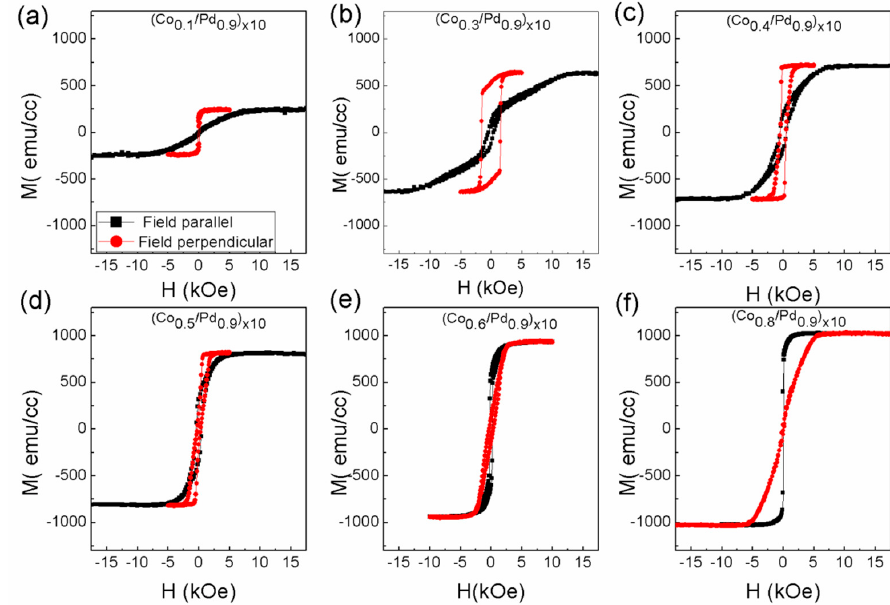
Figure 3. In-plane (black square) and out-of-plane (red circle) magnetic hysteresis loops for the sample ( a ) (Co 0.1 /Pd 0.9 ) ×10 , ( b ) (Co 0.3 /Pd 0.9 ) ×10 , ( c ) (Co 0.4 /Pd 0.9 ) ×10 , ( d ) (Co 0.5 /Pd 0.9 ) ×10 , ( e ) (Co 0.6 /Pd 0.9 ) ×10 , ( f ) (Co 0.8 /Pd 0.9 ) ×10 of series 2.